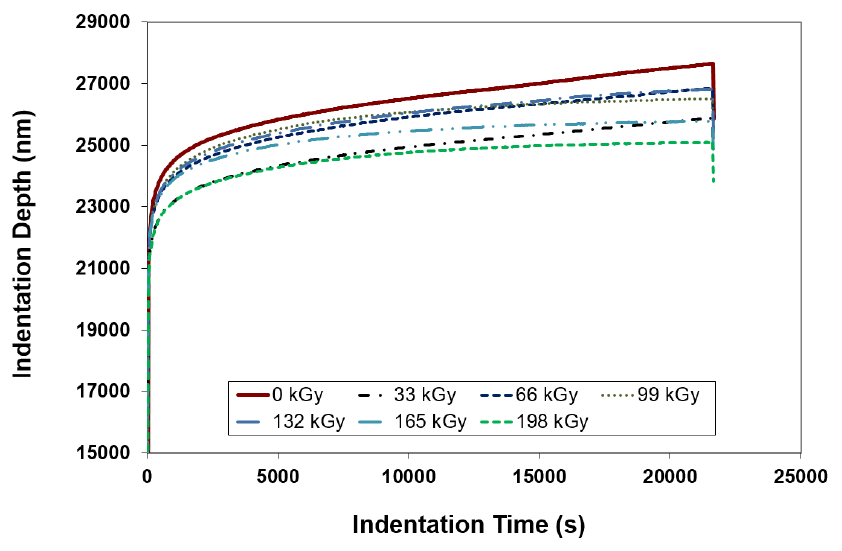
Figure 1. Dependence of indentation depth vs. indentation time of tested PA 6.